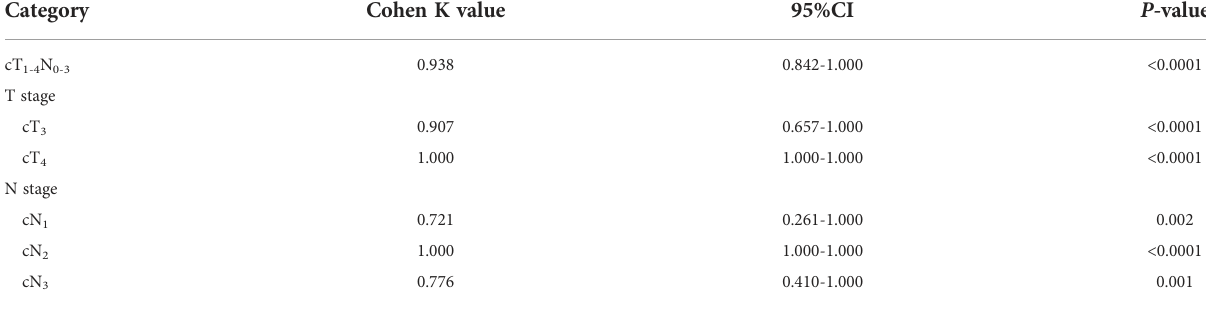
TABLE 5 Cohen ’ s kappa tests in the validation cohort for verifying the performance of our receiver operating characteristic models. Category